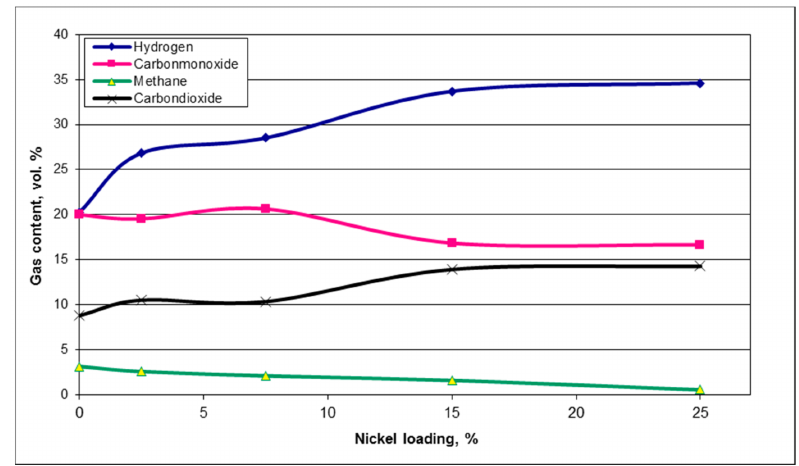
Figure 8. Effect of nickel loading on gas composition. Initial gas composition: H 2 (20%), CO (20%),